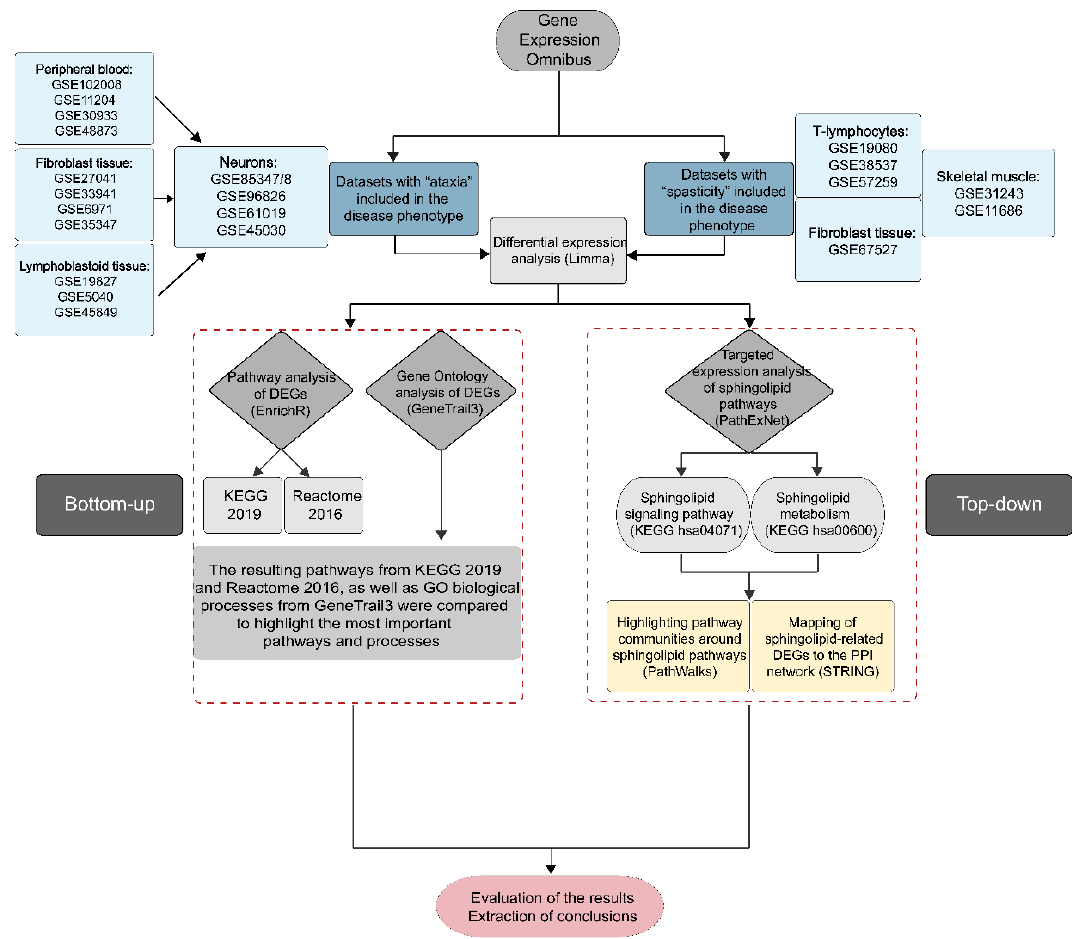
Figure 6. The workflow of our study begins with the download of human gene expression microarray datasets from Gene Expression Omnibus (GEO) using the terms “ataxia” or “spasticity”. Di ff erential expression analysis is then performed using the Limma package of R Bioconductor to produce lists with di ff erentially expressed genes for each dataset. The results of di ff erential expression analysis are used for pathway analysis using the PathExNet tool for the evaluation of the sphingolipid signaling pathway and sphingolipid metabolism, as well as in PathWalks for the generation of pathway clusters. The consistent DEGs participating in the two selected pathways are also used for PPI network construction using STRING and Cytoscape. Pathway enrichment analysis is also performed through EnrichR using the KEGG 2019 and Reactome 2016 as database